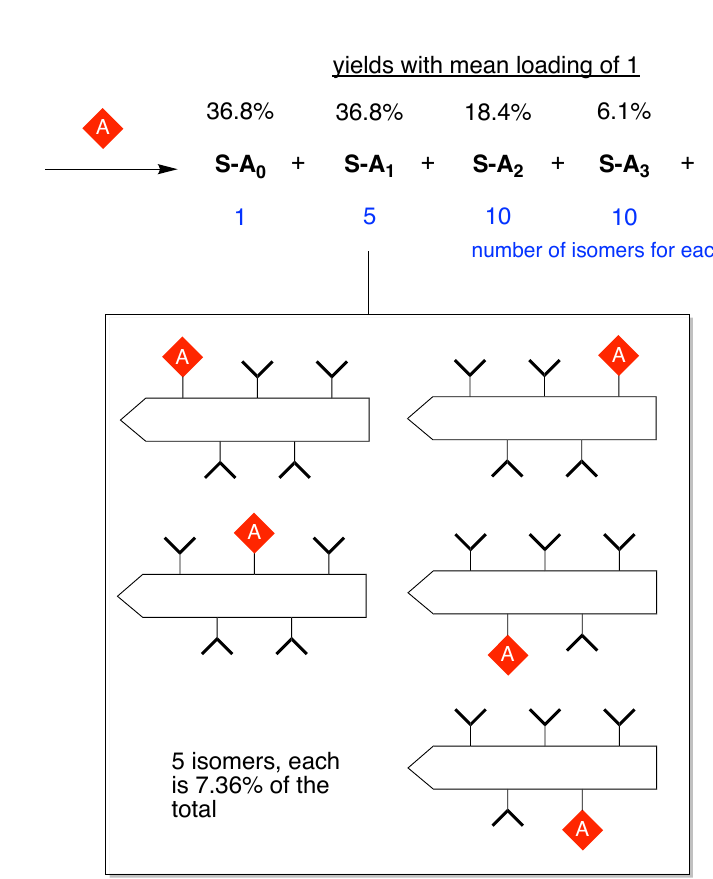
Figure 3. Hub molecules described herein.